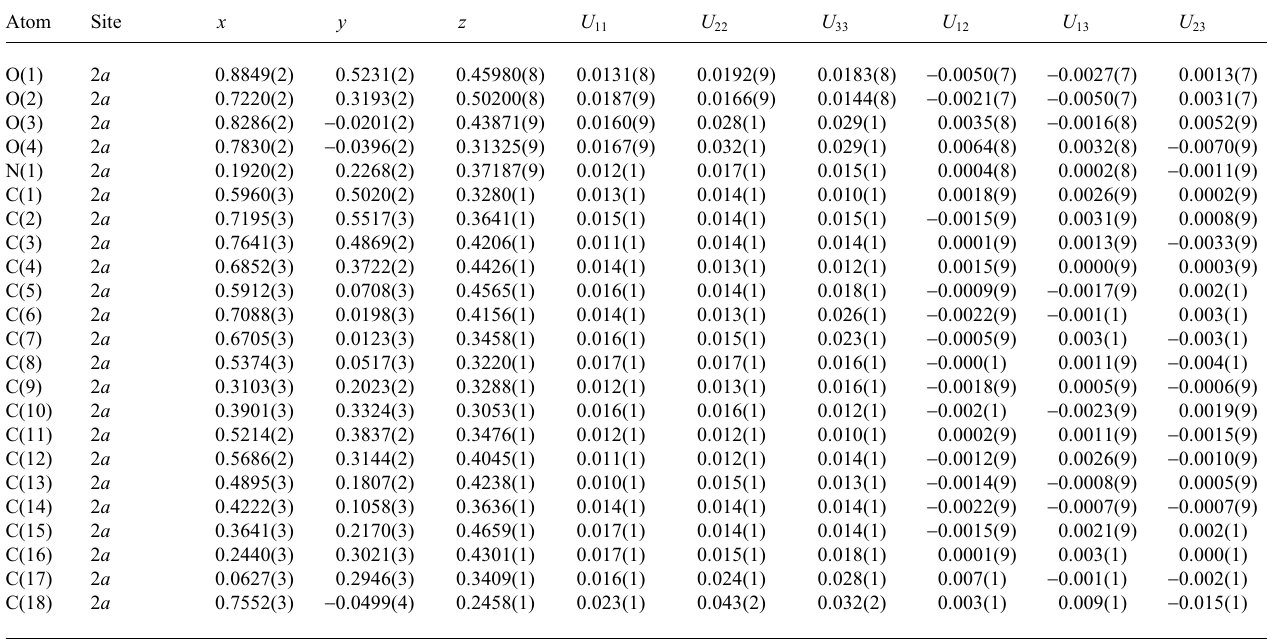
Table 3. Atomic coordinates and displacement parameters (in Å 2 ).